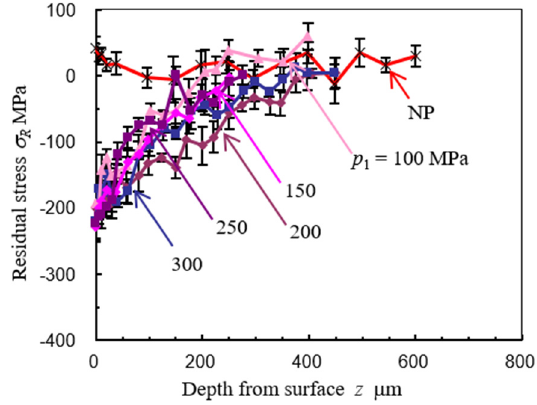
Figure 16. Effect of injection pressure on introduction of compressive residual stress (stainless steel) [100].